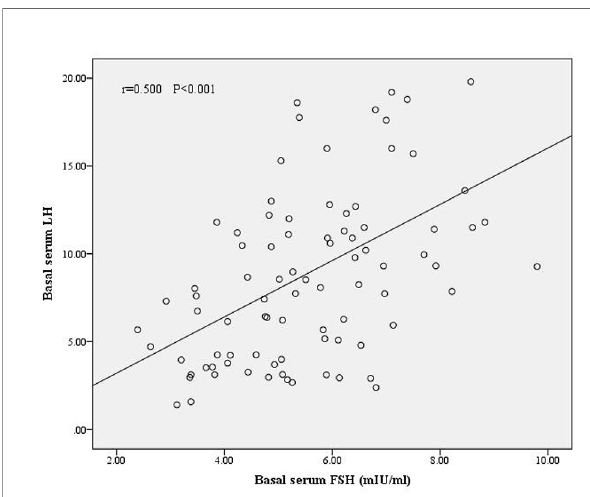
FIGURE 2 | Correlation between basal serum FSH and LH. There was a signi fi cant linear correlation between FSH and LH (r = 0.500, P < 0.001).